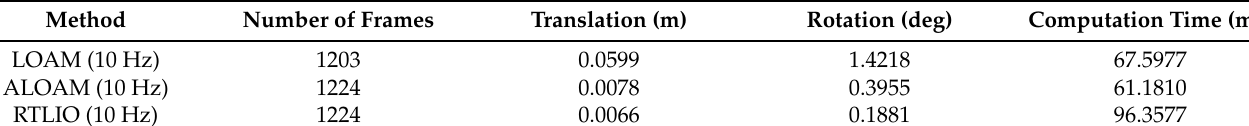
Table 2. Comparison of RMSE of RPE and average time costs for the RTLIO, ALOAM and LOAM methods.